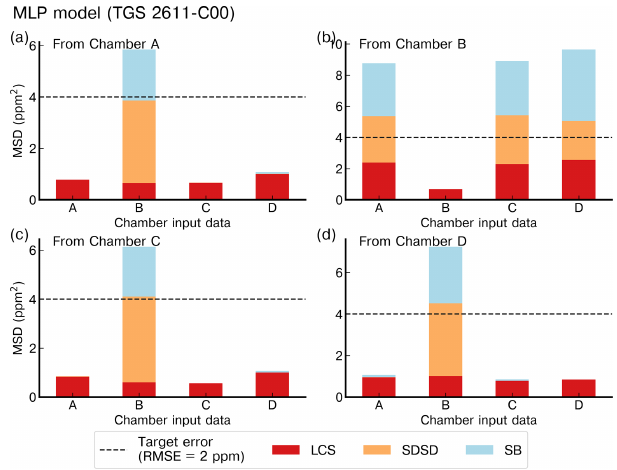
Figure A7. Reconstruction error of the peaks for the MLP model with the TGS 2611-E00 as input and using the best stratified train- ing on (a) chamber A, (b) chamber B, (c) chamber C and (d) cham- ber D. The first column on each panel is the reconstruction error on the test set of the chamber on which the training was done; the other columns are the reconstruction on the whole dataset for that chamber on the same sensor. Note the different ranges of the y